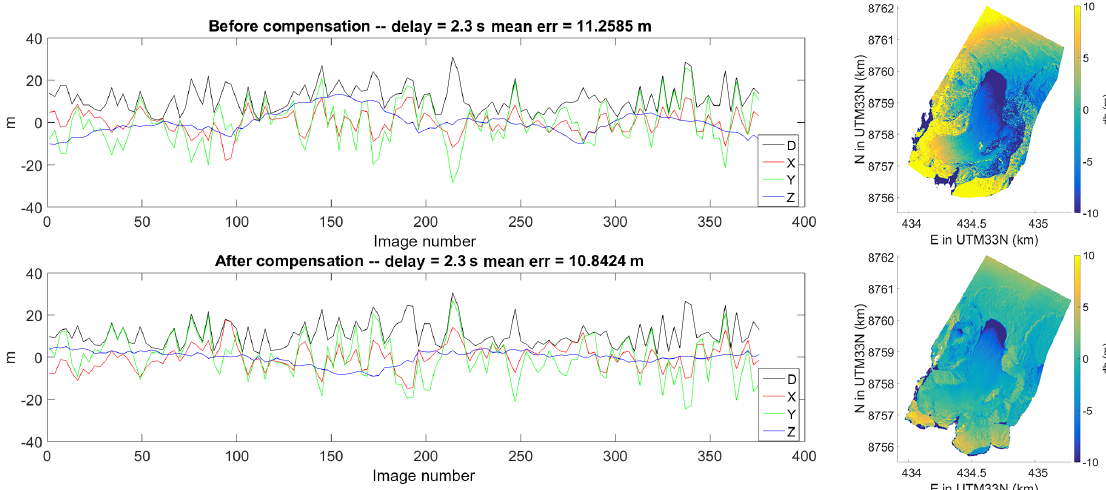
Figure 7. Residuals of the fit between the GNSS-extracted positions and the relative SfM-based orientation of the images, before and after the GNSS-guided bundle adjustment for the 2015 flight. There is a systematic error in the z axis coming from a misestimated focal length (each of the four “bumps” in the blue line representing the residuals in the z axis in the upper panel corresponds to a line of flight; Fig. 9). Right- hand panels show the DEM differences to a reference DEM from 2010. The non-compensated DEM (upper-right panel) has a significantly stronger dome-shaped distortion pattern. After correction, the magnitude of the doming is less than the precision of the GPS.